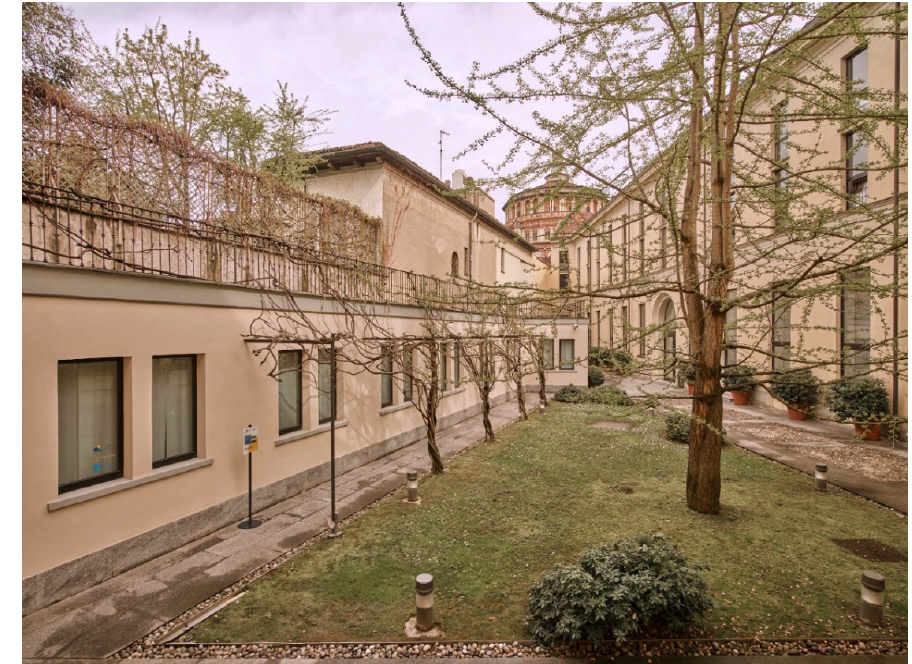
Figure 8. The complex articulation of WeMi Stelline. Source: Courtesy of Giovanni Hänninen. functions that was made possible by the strong versatile use of spaces managed through light tools and interven‐ tions: “Hug‐WeMi is a cafeteria and a space for cultural events at the same time. All you need is to move the cur‐ tains. Also, we organise workshops and meetings on care‐ related issues, such as parenthood and disability” (social operator of WeMi Venini).